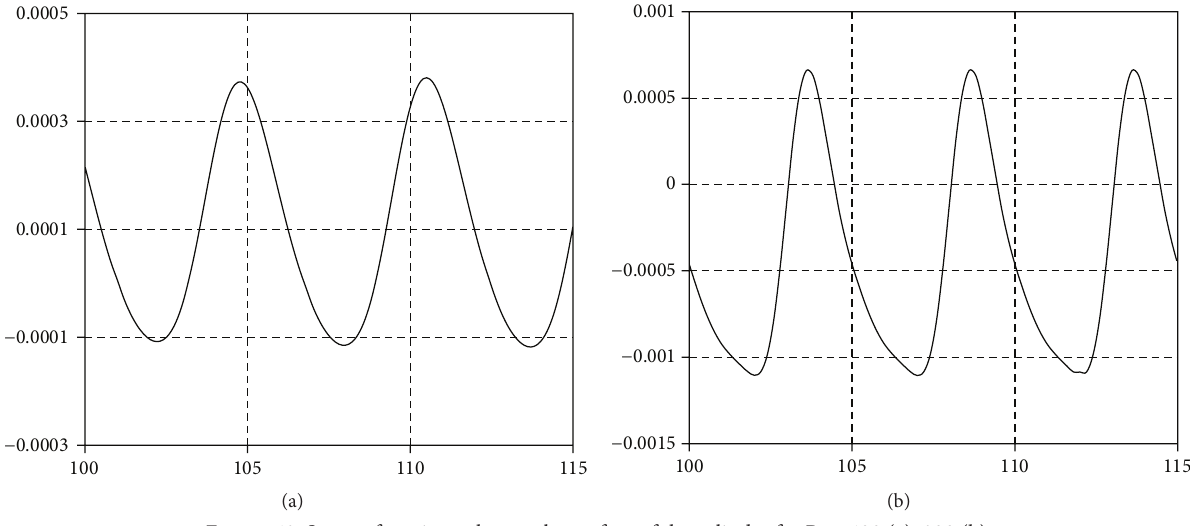
Figure 12: Stream function value on the surface of the cylinder for Re = 100 (a), 200